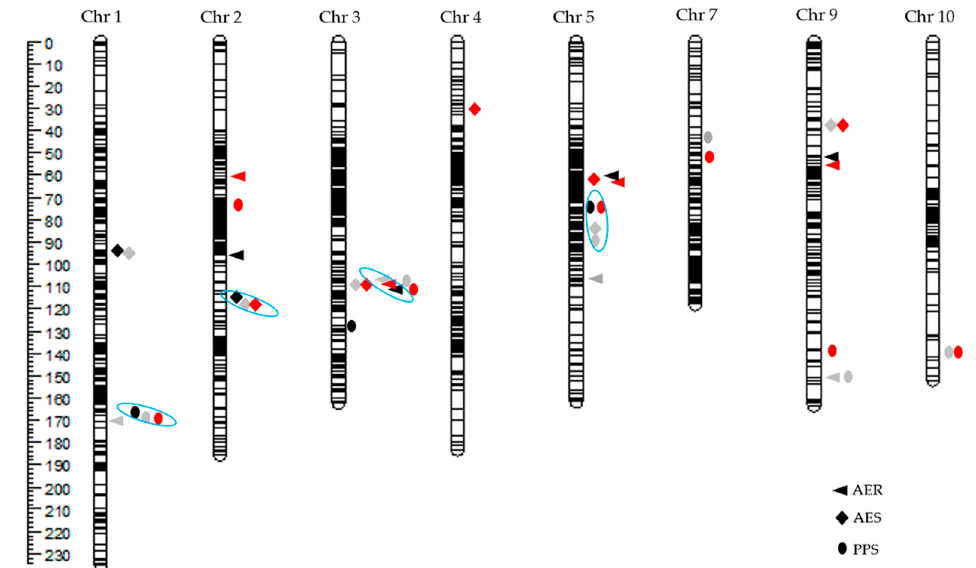
Figure 2. Genetic map and chromosomal locations of quantitative trait locus (QTL) associated with HMF-related traits mapped in the doubled haploid population grown in Beijing (black) and Hainan (gray) and across both locations (red). QTL repeatedly identified were shown in blue circle. Table 1. Putative QTL detected for AER in the haploid mapping population.